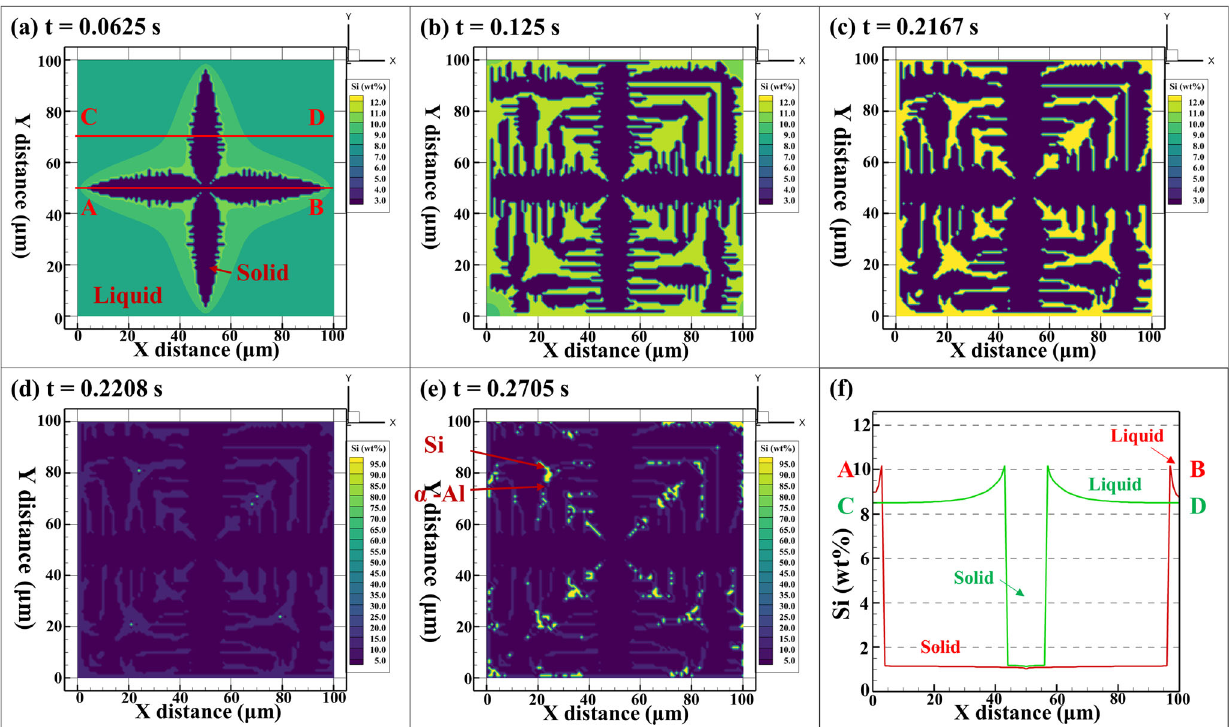
Fig. 1 Singe dendrite morphology. Singe dendrite morphology and the solute concentration fi eld: a At 0.0625 s, b at 0.125 s, c at 0.2167, d at 0.2208 s, e at 0.2705 s, and f solute concentration distribution along A – B and C – D in ( a